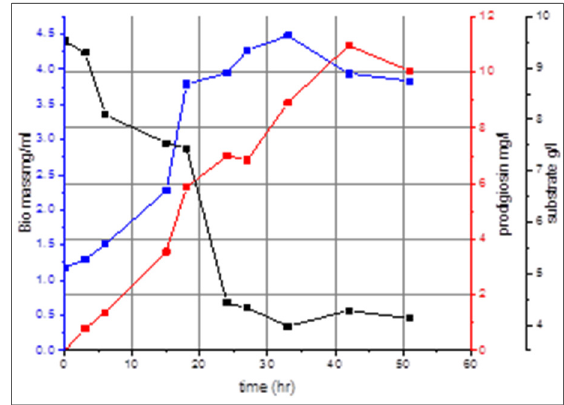
Fig. 8. Time course of cell growth ( ■ ), substrate consumption ( ■ ) and prodigiosin production ( ■ ) by S. marcescens in un-optimized medium in shaker incubator at 200 rpm and 30